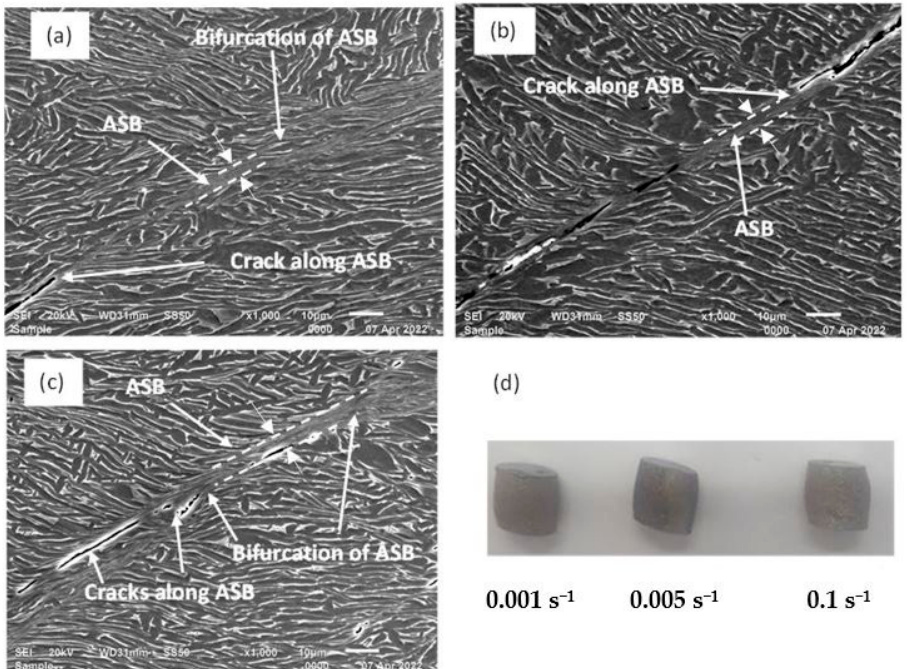
Figure 15. Typical shear-deformed surfaces of samples D after tests at strain rates of ( a ) 0.001 s − 1 , ( b ) 0.005 s − 1 and ( c ) 0.1 s − 1 , while ( d ) shows the typical condition of the test samples after testing at the respective strain rates.